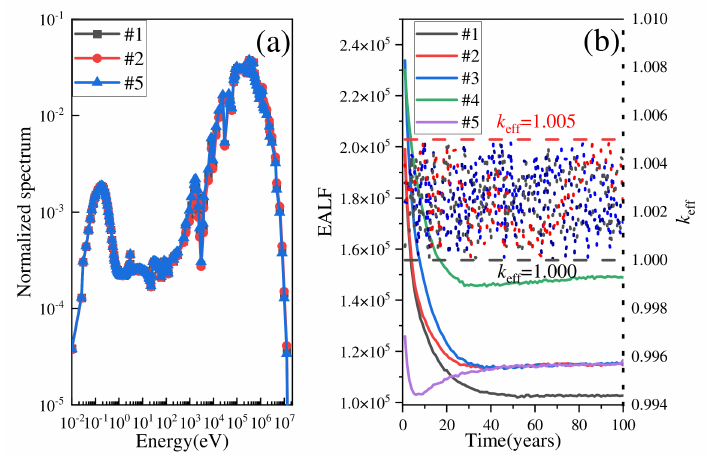
Figure 5. Normalized spectrum ( a ) and evolution of EALF and k eff ( b